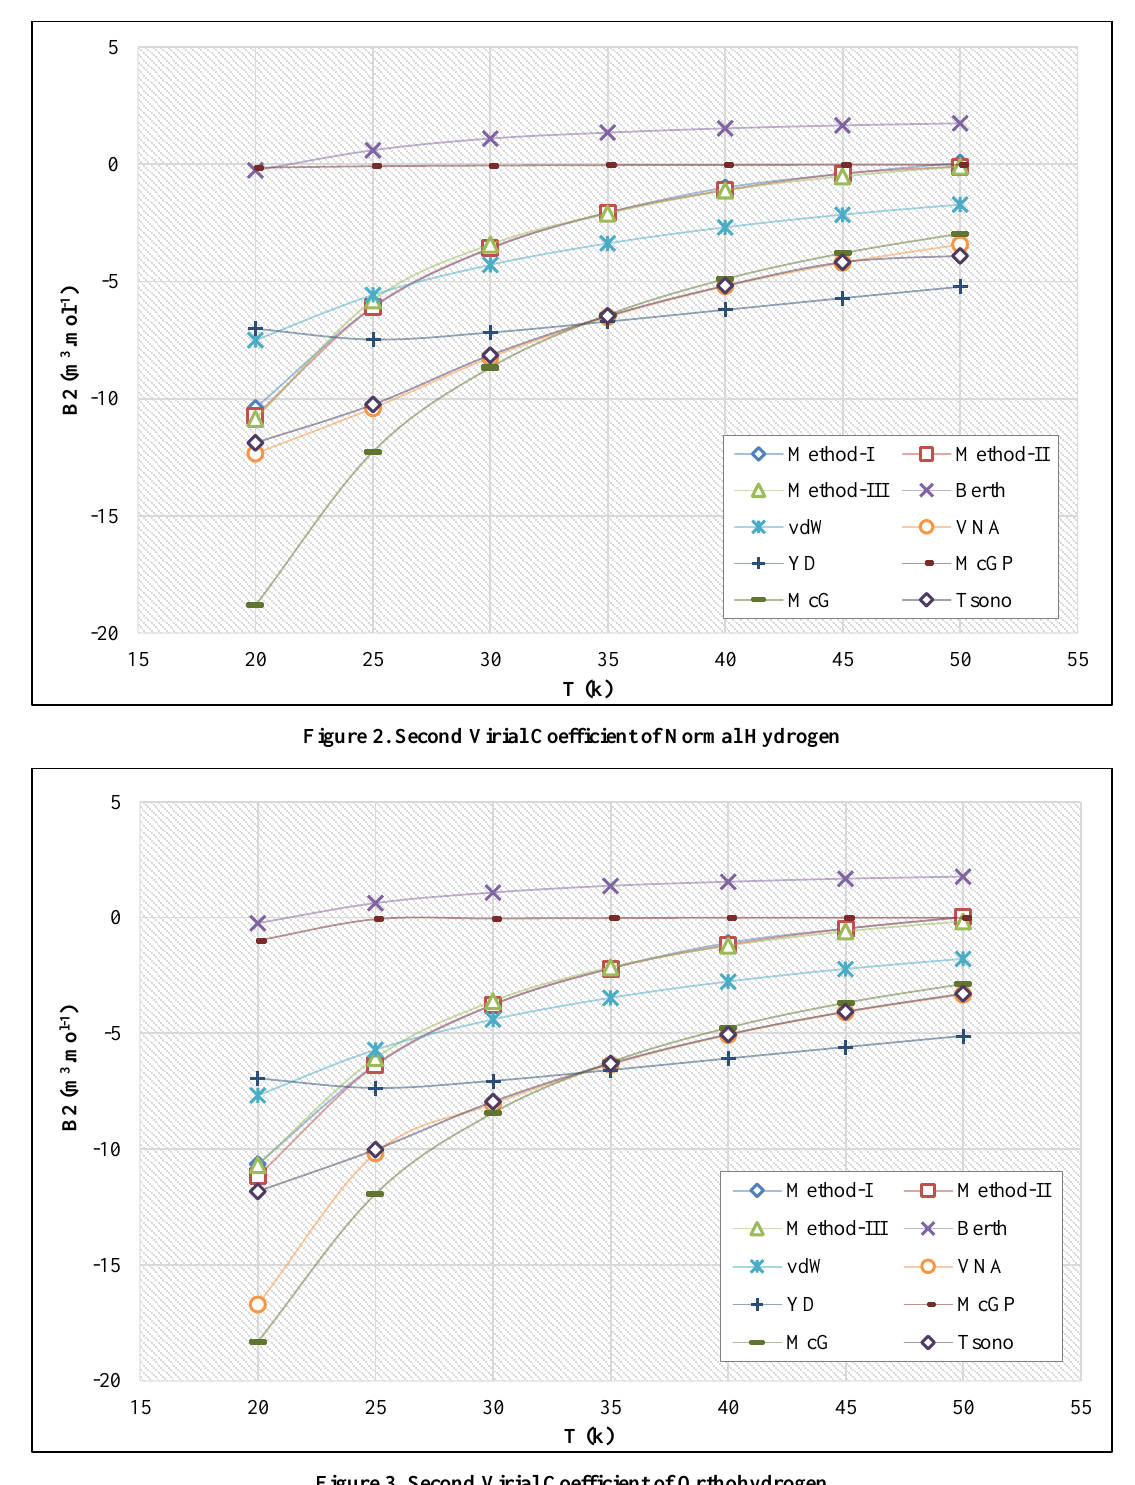
Figure 3. Second Virial Coefficient of